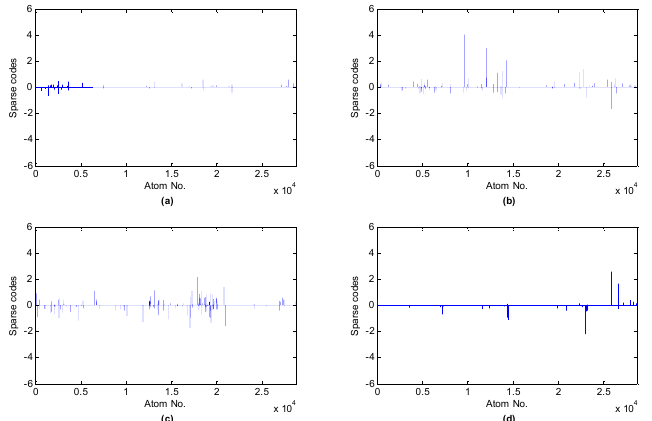
Figure 5. Shift invariant sparse coefficients with respect to different running statuses: ( a ) normal; ( b ) inner race fault; ( c ) rolling element fault; ( d ) outer race fault.